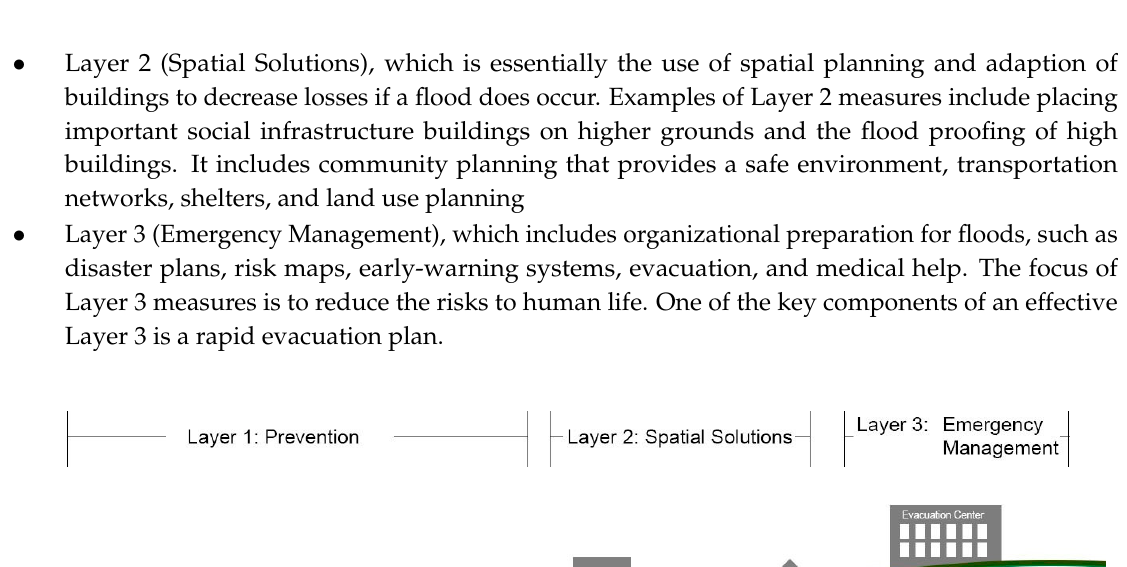
Figure 8. The new dyke in Kirikiri was rebuilt to a higher level. Figure 9. Significant parts of Kirikiri were elevated, as part of the multi-layer safety defence. Picture shows houses constructed on elevated land.